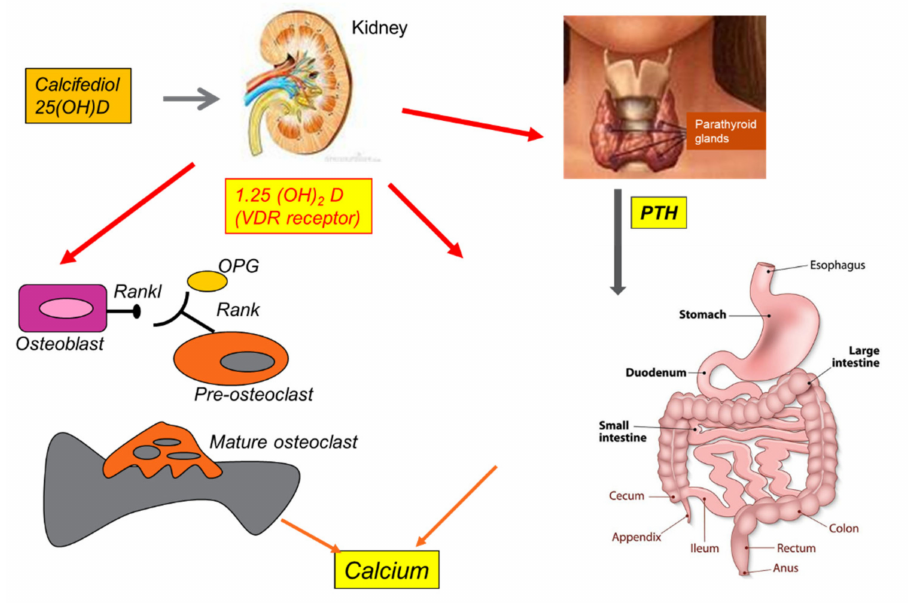
Figure 4. Summary of Vitamin D effects on human bone, thyroid, kidney, and calcium